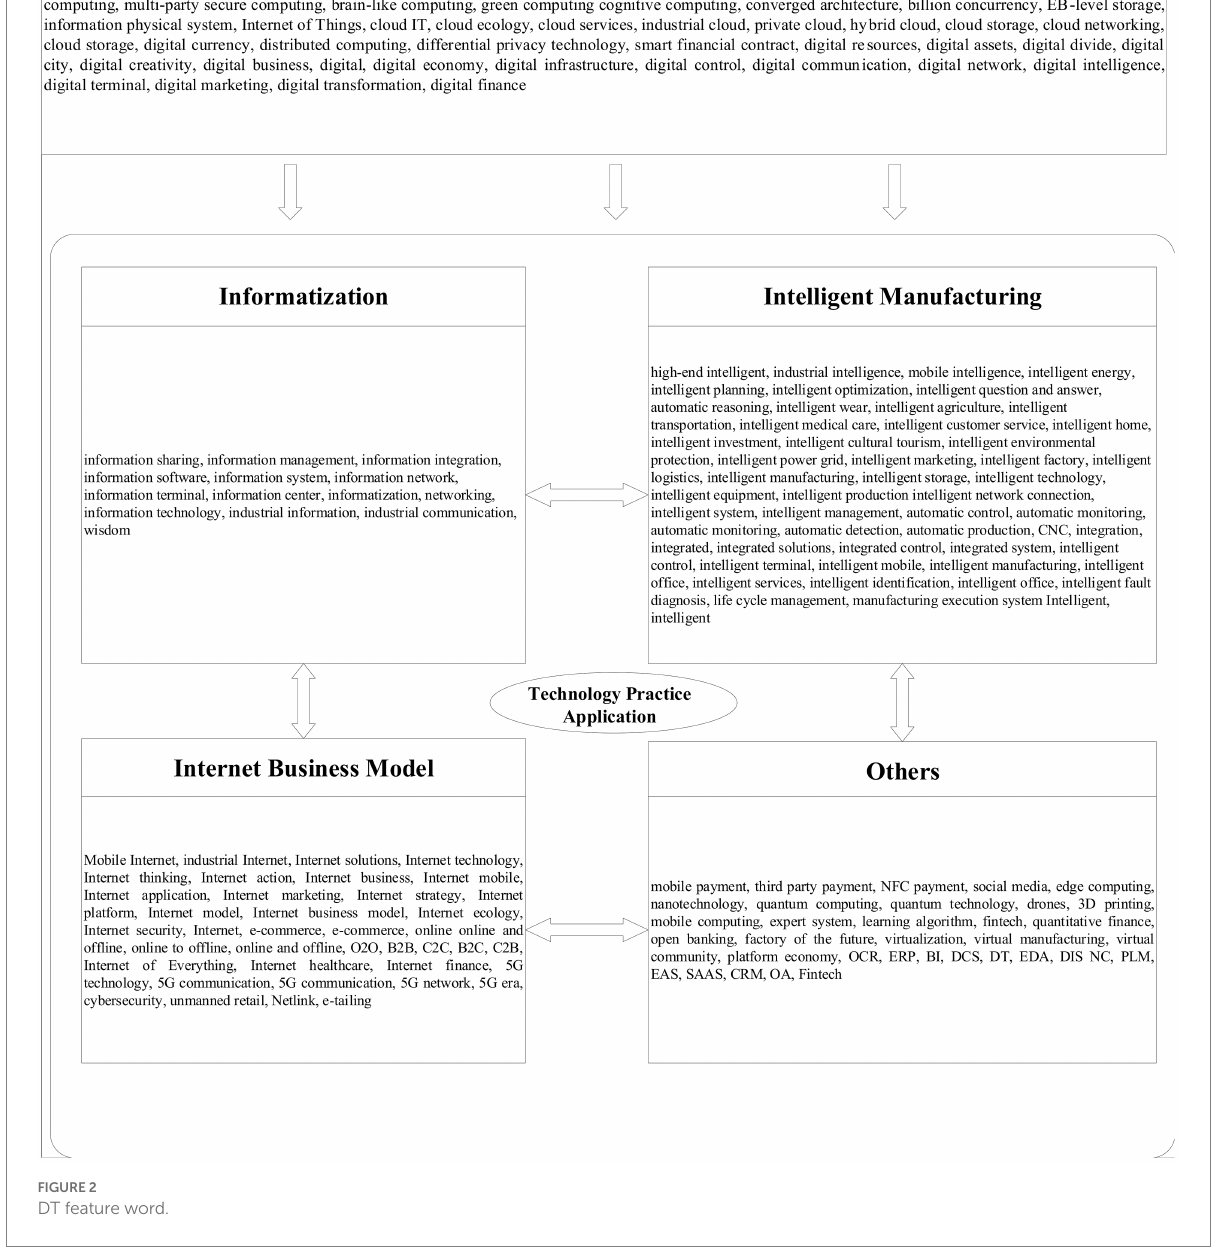
FIGURE 2 DT feature